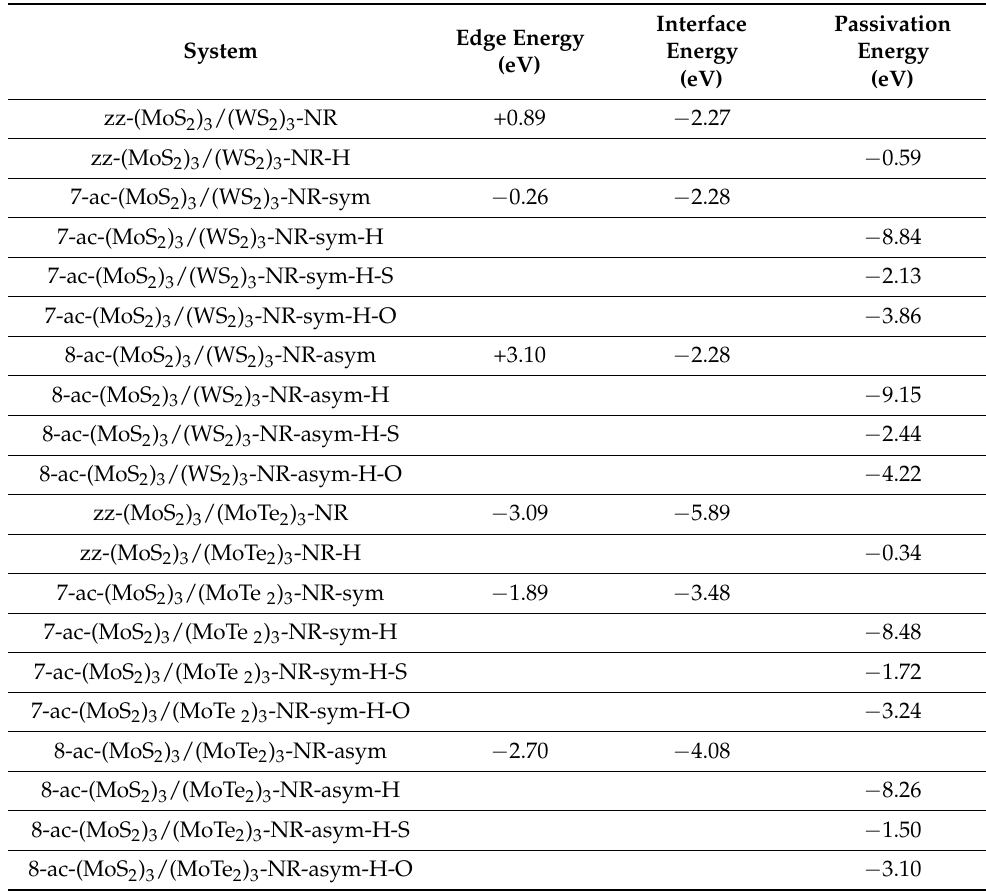
Table 1. Edge, interface and passivation energies per interface unit cell of zig-zag and